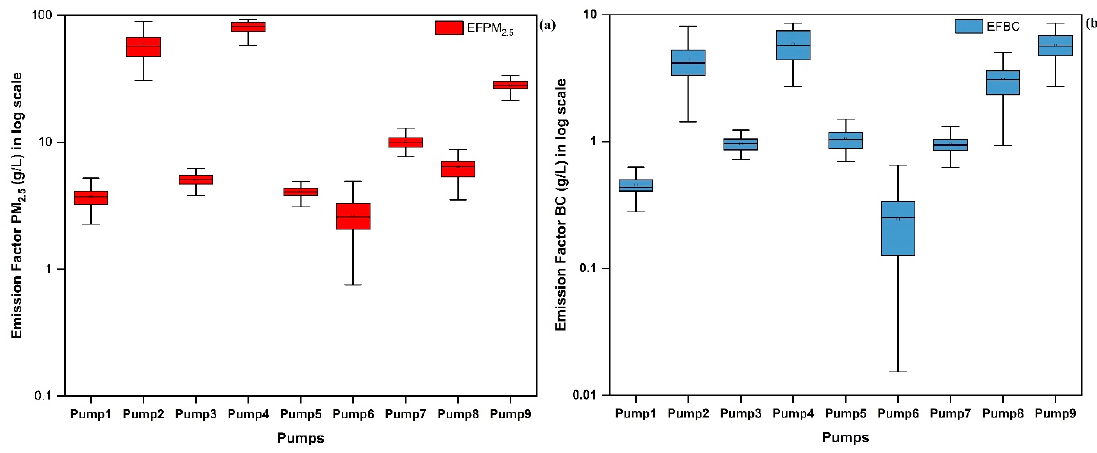
Figure 4. Box plot showing EFPM 2.5 (g/L) ( a ) and EFBC (g/L) ( b ) in log scale for all measured pumps. The lower and upper edge of each box represent the 25th and 75th percentiles, respectively; the top and bottom of the whisker represent the 90th and 10th percentiles, respectively. The square box mark within each box represents the average EF and the horizontal mid-line in each box represents the median. EF, emission factors; EFPM 2.5, emission factors particulate matter with less than 2.5 µ m diameter; EFBC, emission factors black carbon.